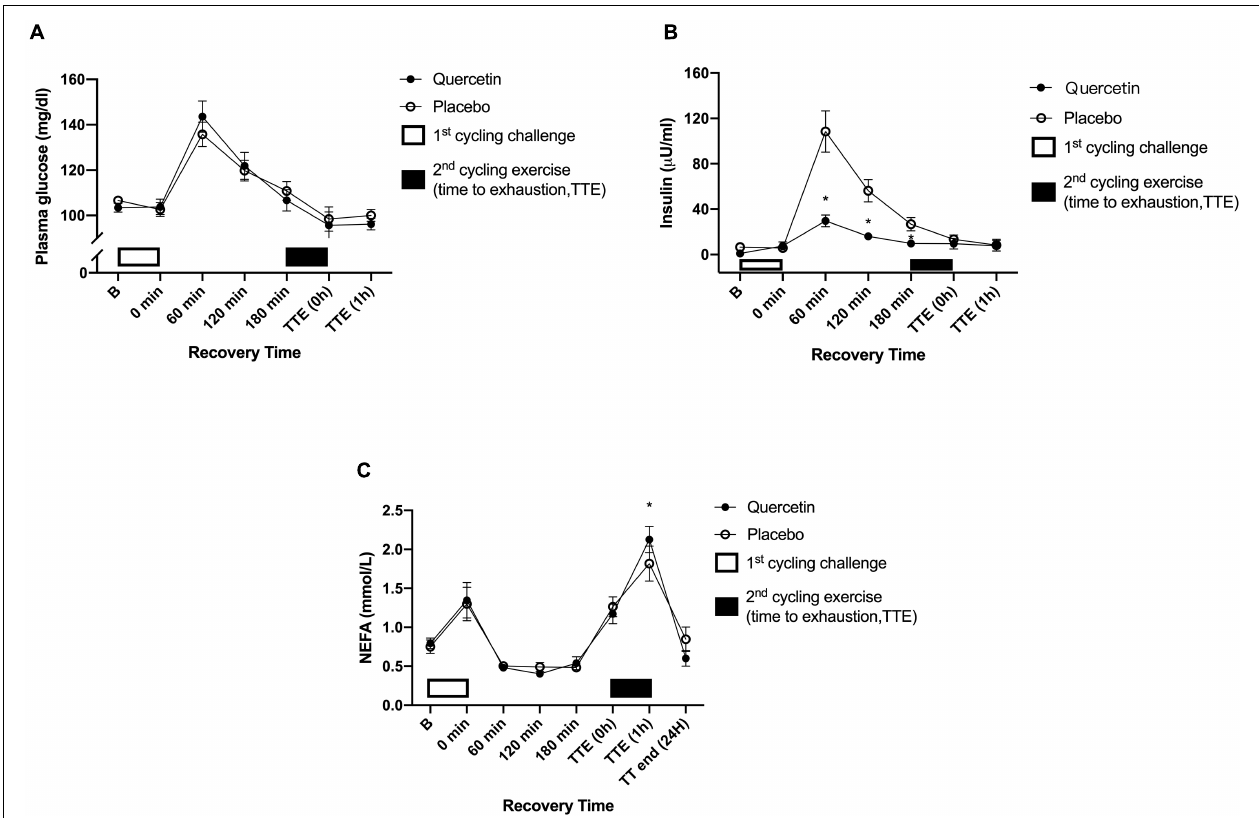
FIGURE 3 | Blood glucose (A) , plasm insulin (B) , and plasma non-esterified fatty acids (NEFA) (C) concentrations in (- • -) quercetin and (- ◦ -) placebo trials. B represents before the first cycling challenge. TTE (0,1 h,24 h): represents immediately, 1-h, and 24-h after the second cycling exercise, respectively. *Significant difference between quercetin and placebo ( p < 0.05). Values are expressed as mean ± SE, N =